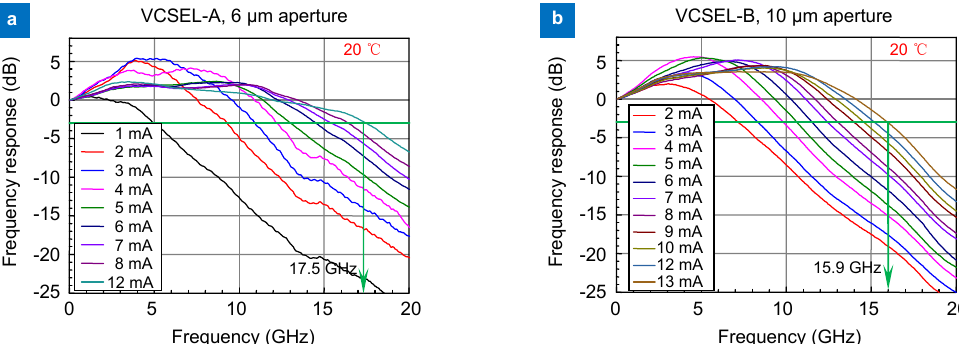
Fig. 7 | Frequency responses of the VSCELs with ( a ) 6- μ m and ( b ) 10- μ m oxide confined apertures under different bias current conditions